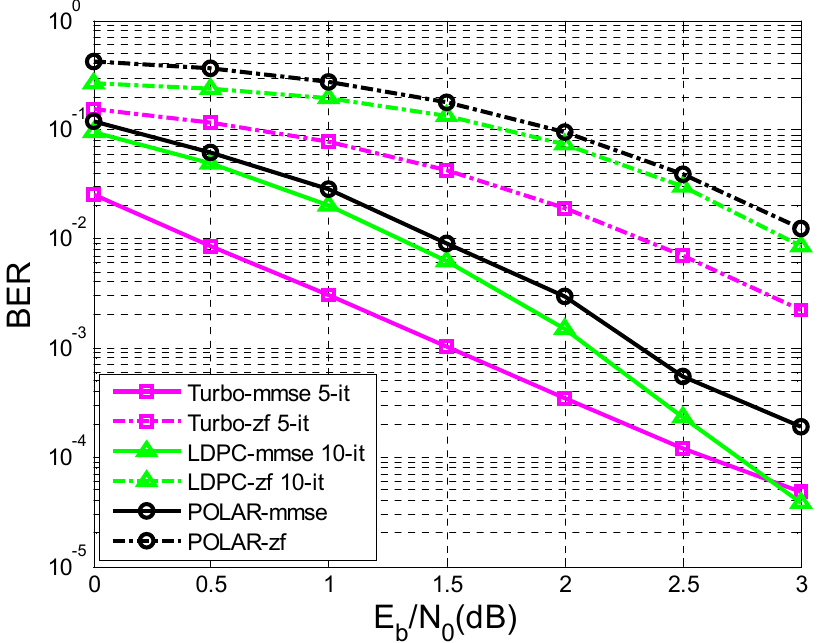
Figure 12. BER vs. SNR for different codes in the case of MMSE and ZF equalization in the case of perfect channel estimation (K = 170 bits and h = (0.18 0.85 0.32)).